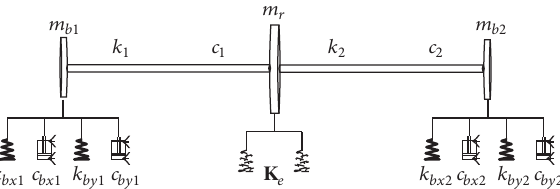
Figure 2: The simplified model of a motorized spindle system.